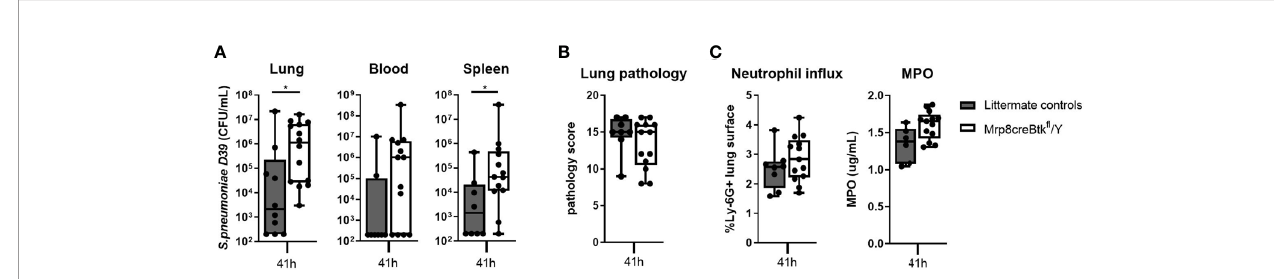
FIGURE 5 | Neutrophil speci fi c Btk expression is essential for host defense against D39 pneumococci. (A) Bacterial loads in lung, blood and spleen of Mrp8creBtk fl / Y (n=10) mice and littermate controls (n=14) 41 hours after intranasal inoculated with D39. (B) Pathology score. (C) Percentage of Ly-6G positive lung surface and concentrations MPO in lung homogenate. Data are expressed as box- and whisker plots showing the smallest value, lower quartile, median, upper quartile and largest value. *p < 0.05, Mann-Whitney U